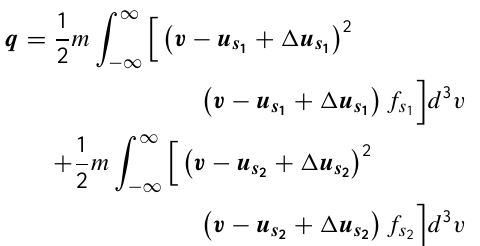
Table 2. Hot O + cooling